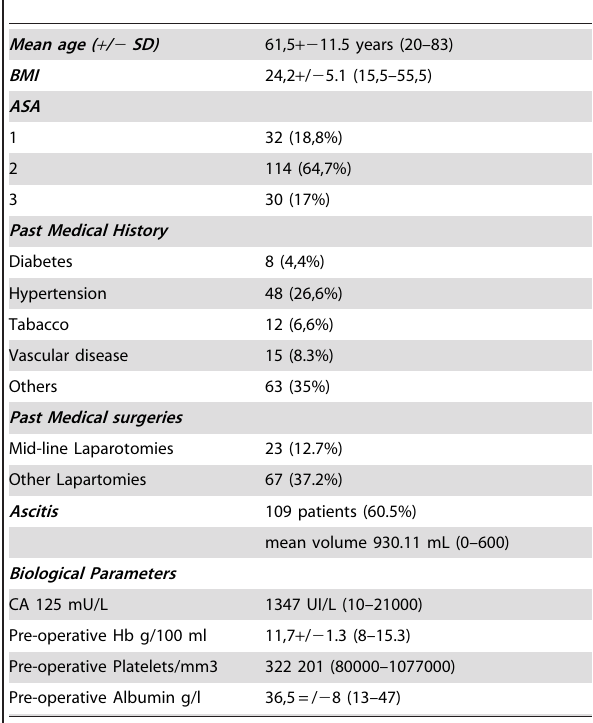
Table 1. Demographic characteristics of the